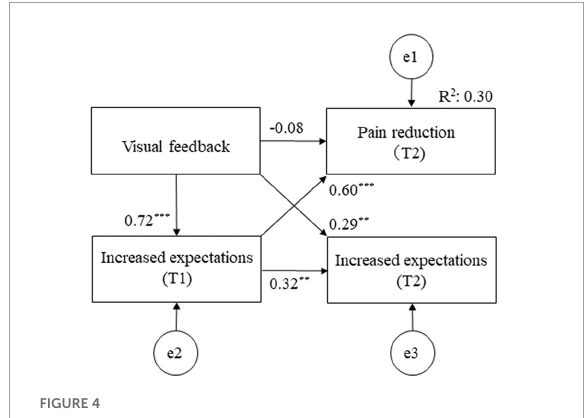
FIGURE4 Path diagram for the final